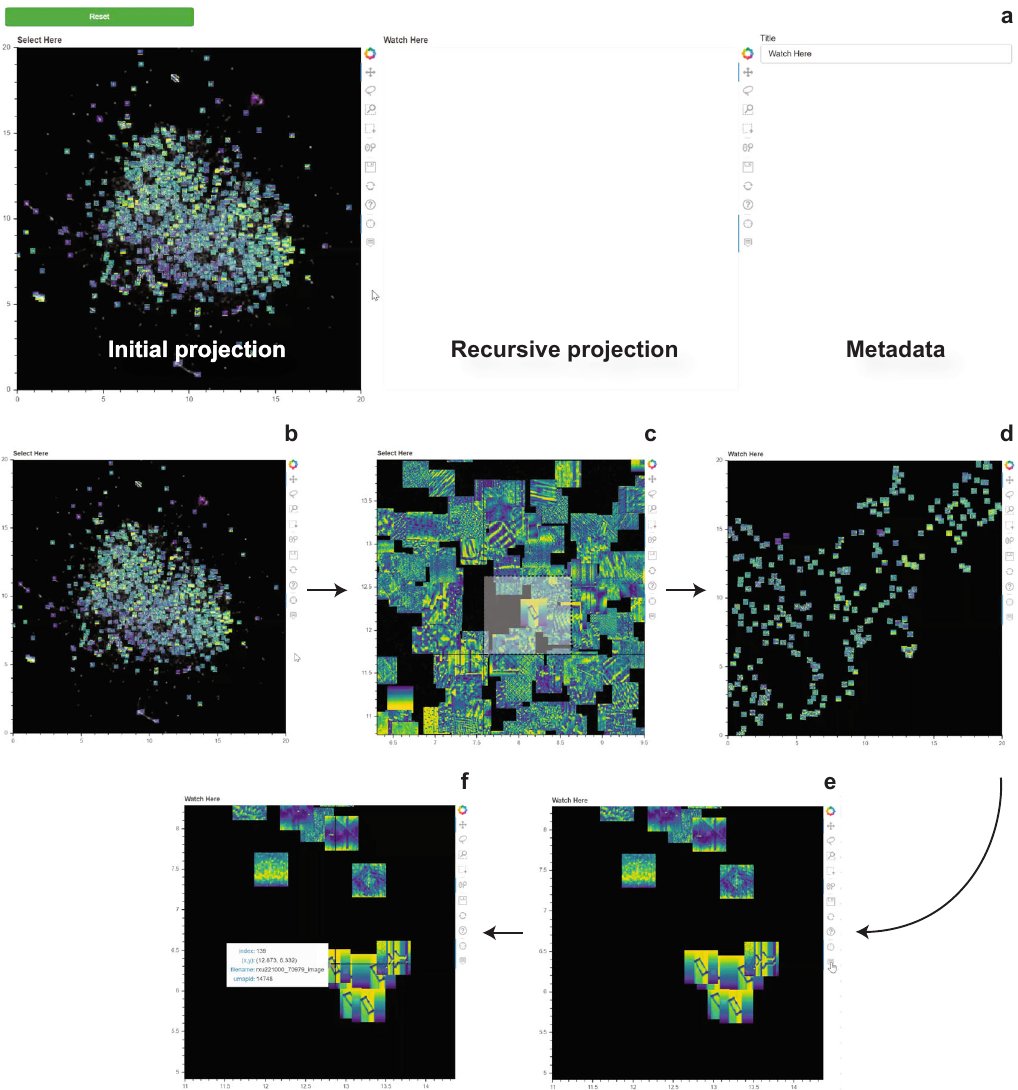
Fig. 6 Demo of interactive graphical user interface of the image similarity latent manifold using the Bokeh Visualization Library. a Graphical user interface outlook on the web browser. b Initial UMAP projection. c Area of interest selection. d Recursive UMAP projection. e Zoom-in view of recursive UMAP projection. f Exploration of the metadata associated with the